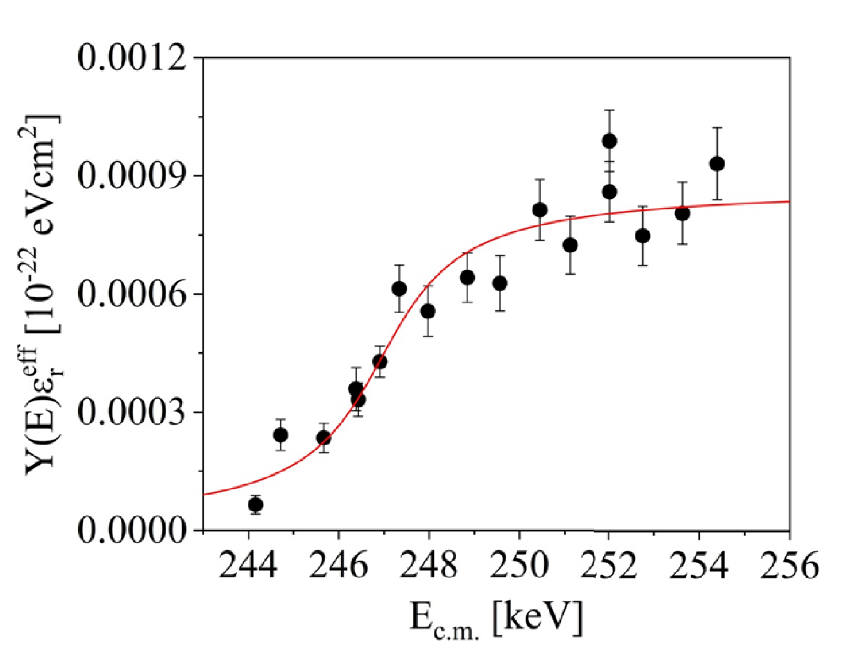
Fig. 4. Gamma-ray yield of the 6175 keV (cid:4) -ray emitted in the decay of the 7556 keV state in 15 O as a function of the center of mass energy. The red line represents a fit with the arctan function